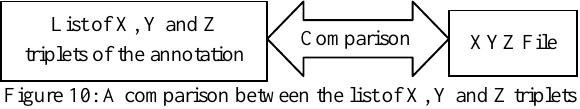
Figure 10: A comparison between the list of X, Y and Z triplets